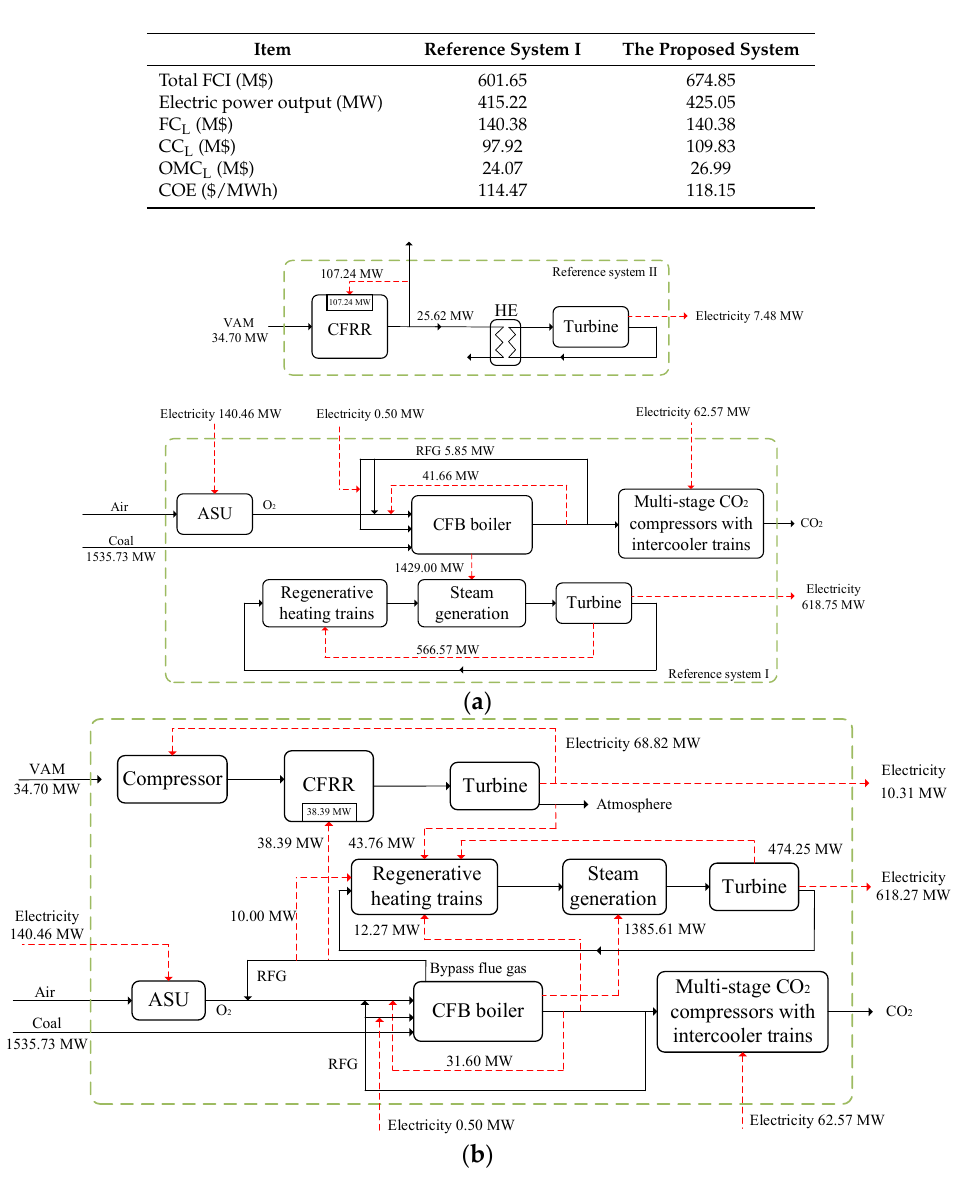
Figure 4. Energy and material flow diagrams of the ( a ) reference systems; ( b ) the proposed system.